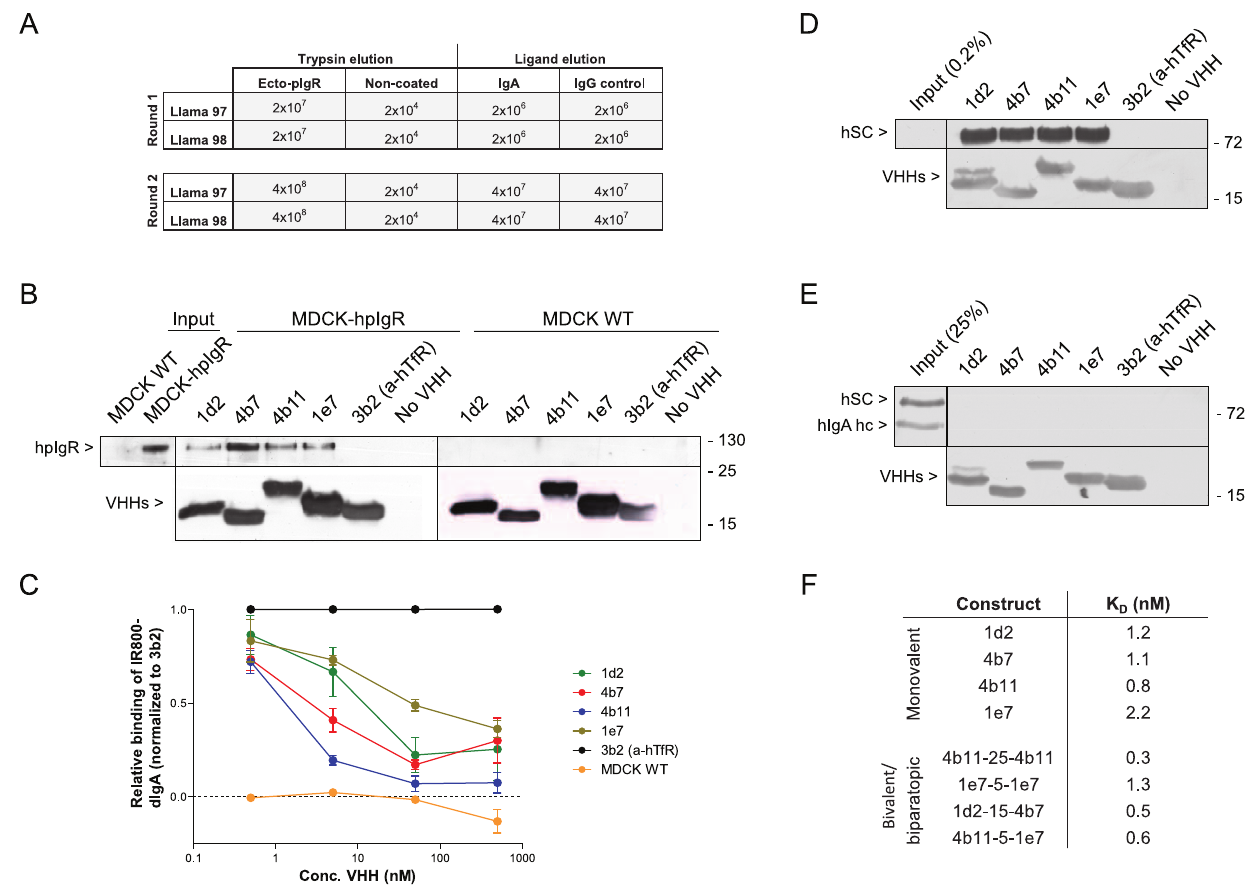
Figure 1. Selection and validation of VHHs against hpIgR. (A) Outputs of phage display selection on coated recombinant hpIgR ectodomain with either trypsin or IgA elution for llama’s 97 and 98. (B) Pull down of VHHs with incubated cell lysate of MDCK control (right) or MDCK-hpIgR (left) cells with the anti-his matrix Talon. Western blot with anti-hSC and anti-myc tag (VHH) (n=3). (C) A critical amount of IR800 labelled dIgA with indicated amount of VHHs was incubated on MDCK-hpIgR cells at 4 u C for 1.5 h. The normalized amount of IR800-dIgA is calculated and set out in the graph against the VHH concentration (n=4) (s.e.m.’s are shown for all points). (D + E) Pull down of VHHs incubated in MDCK-hpIgR cultured medium containing hSC (D) or with 4 m g/ml sIgA (E). Western blot with anti-hSC, anti-hIgA heavy chain and anti-myc (n=4). (F) VHHs were titrated and put on cells for 1.5 h at 4 u C. VHH presence was quantified by using anti-myc tag and D- a -M-IR800 antibodies. Quantification as described in experimental procedures. K D determinations were done with a ‘one-site specific binding’ algorithm in Graphpad. (n=6).